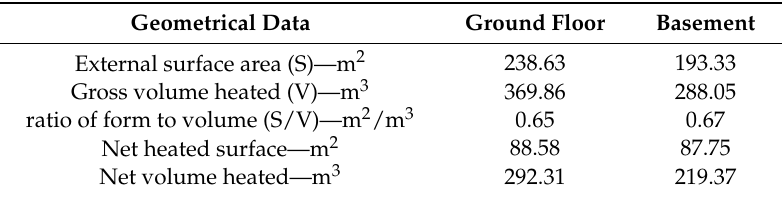
Table 2. Ground floor and basement geometrical data.